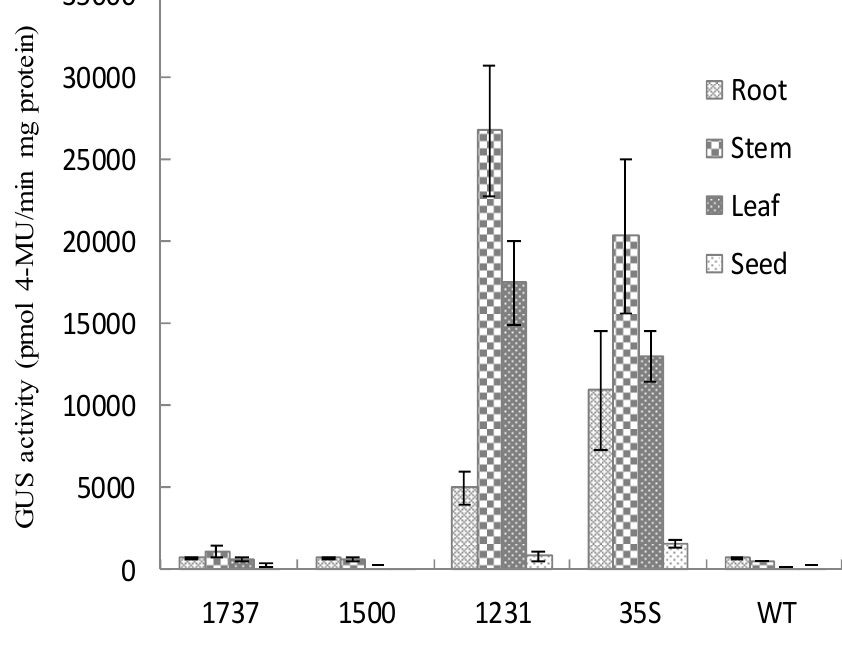
Figure 6. GUS activity of different tissues of transgenic tobacco plants. Data was shown as average ± S.E. of n independent transgenic lines, n = 3 for 1737, 1500 and WT; n = 6 for 1231 and